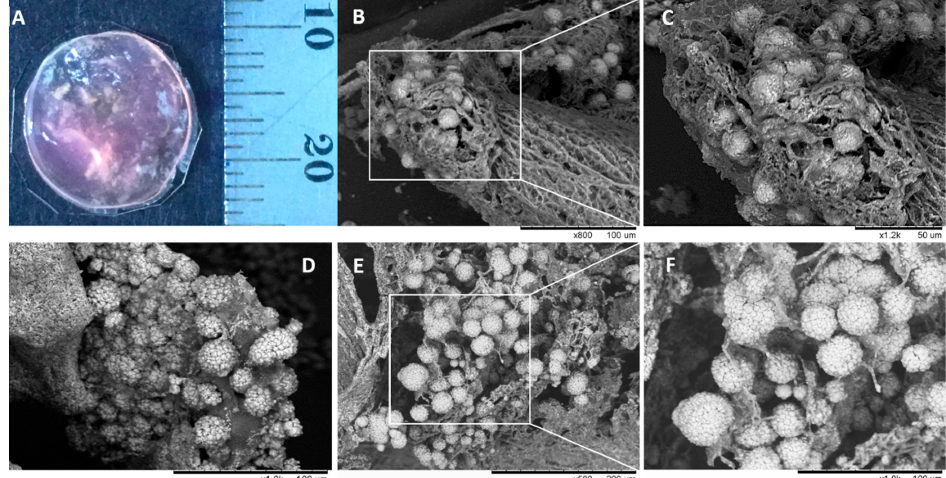
Figure 10. ( A ) Digital photograph of the HaCaT clusteroids within an alginate hydrogel film over